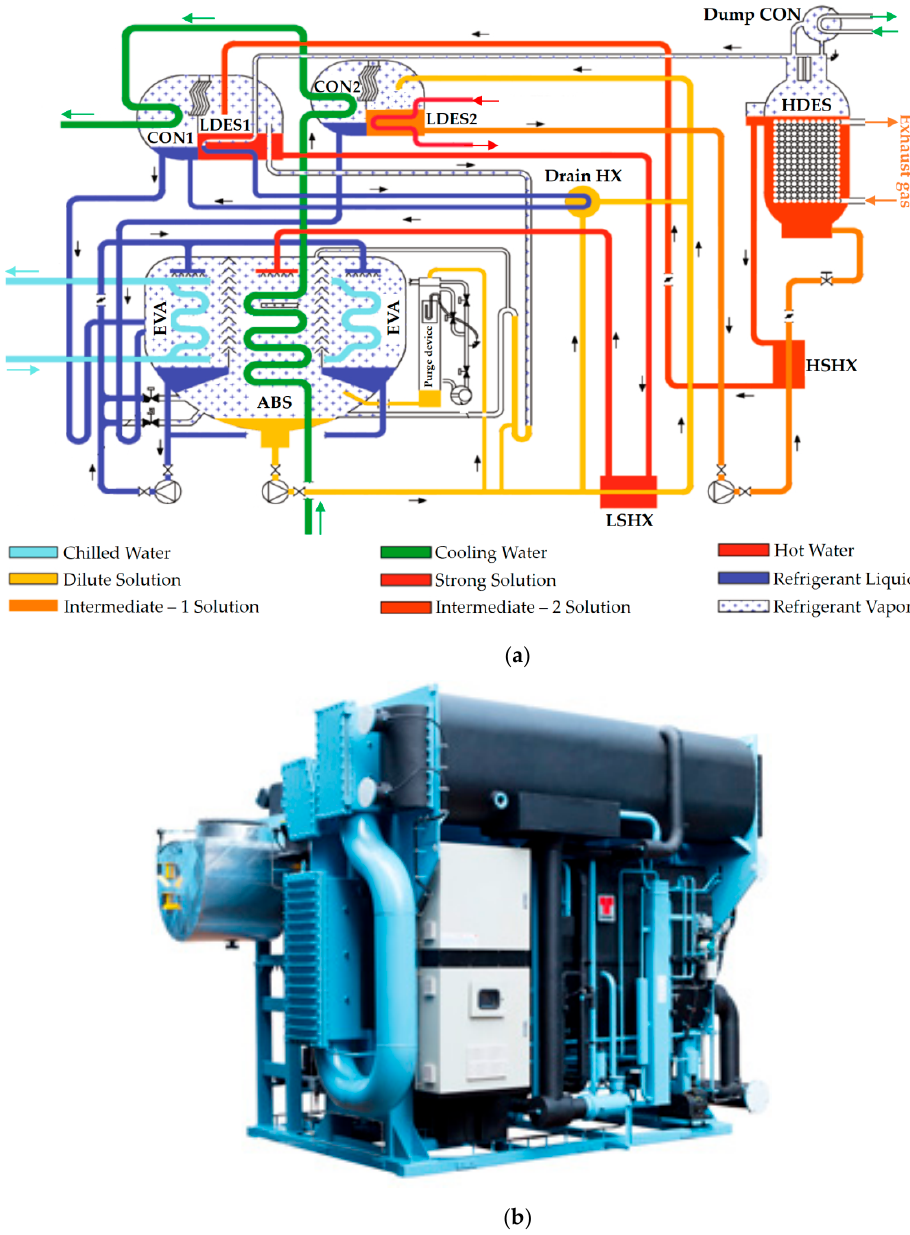
Figure 12. Multi ‐ energy ‐ driven single/double ‐ effect absorption chiller from Thermax Ltd. Adapted Figure 12. Multi-energy-driven single / double-effect absorption chiller from Thermax Ltd. Adapted from from Reference [42]. (a) Absorption cycle schematic; (b) Absorption chiller external view. Note: Reference[42].( a )Absorptioncycleschematic; ( b )Absorptionchillerexternalview. Note: ABS = absorber; ABS=absorber; CON=condenser; EVA=evaporator; HDES=high ‐ temperature desorber; HSHX=high ‐ CON = condenser; EVA = evaporator; HDES = high-temperature desorber; HSHX = high-temperature temperature solution heat exchanger; LDES1=low ‐ temperature desorber; LDES2= low ‐ temperature solution heat exchanger; LDES1 = low-temperature desorber; LDES2 = low-temperature hot-water hot ‐ water desorber; LSHX=low ‐ temperature solution heat exchanger. desorber; LSHX = low-temperature solution heat